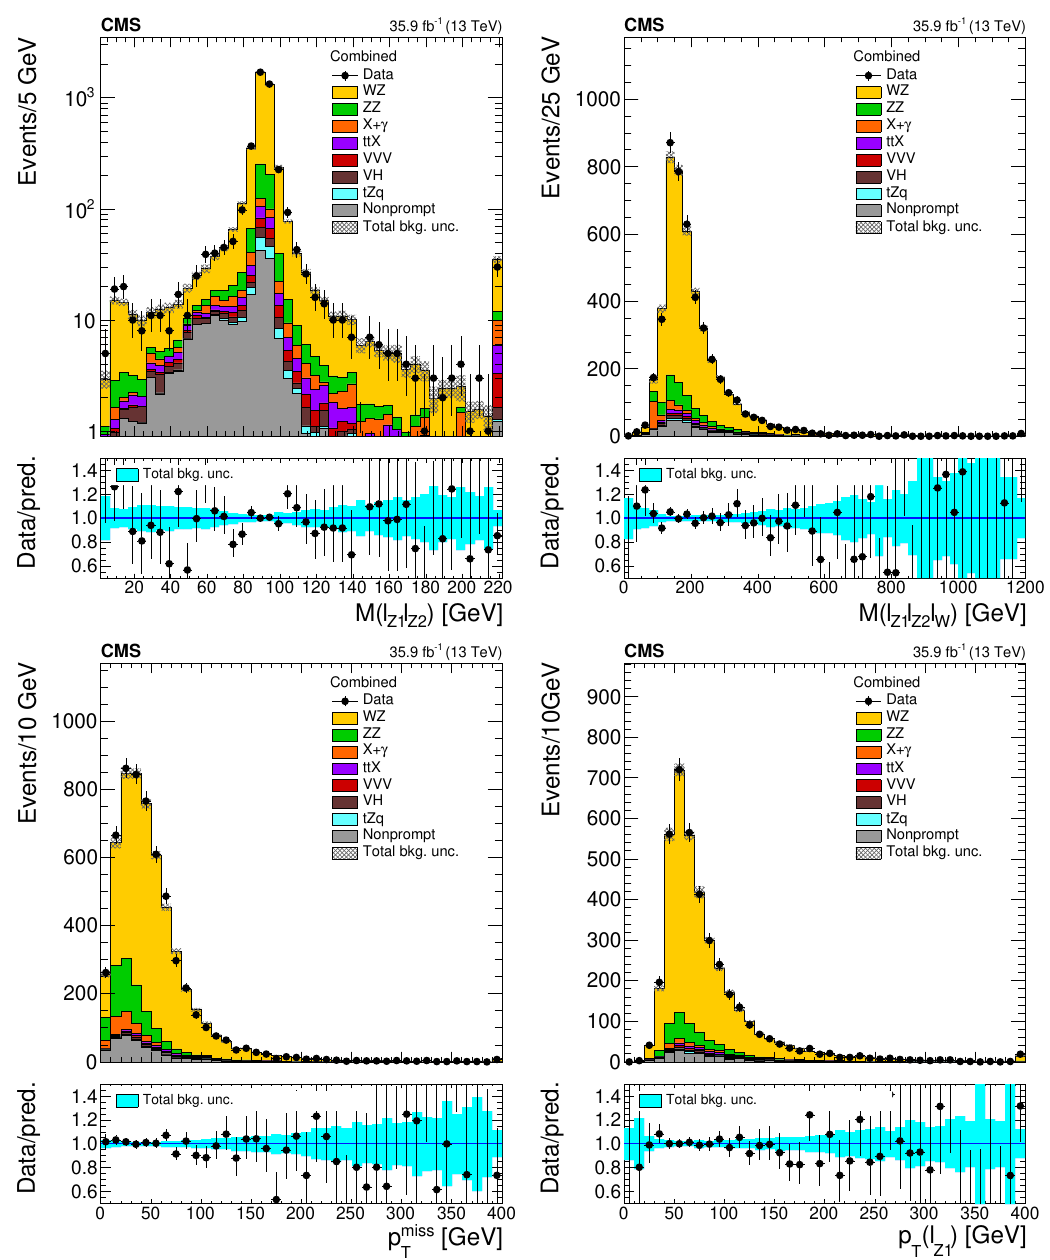
Figure 2 . Distribution of key observables in the signal region after the signal extraction (cid:12)t: invariant mass of the lepton pair assigned to the Z boson (top left), invariant mass of the three- lepton system (top right), missing transverse momentum (bottom left), and transverse momentum of the leading lepton assigned to the Z boson. For each distribution all the signal region requirements are applied except the requirement relating to the particular observable so that the e(cid:11)ect of the requirement on that observable can be easily seen. The last bin contains the over(cid:13)ow. Vertical bars on the data points include the statistical uncertainty and shaded bands over the prediction include the contributions of the di(cid:11)erent sources of uncertainty at their values after the signal extraction